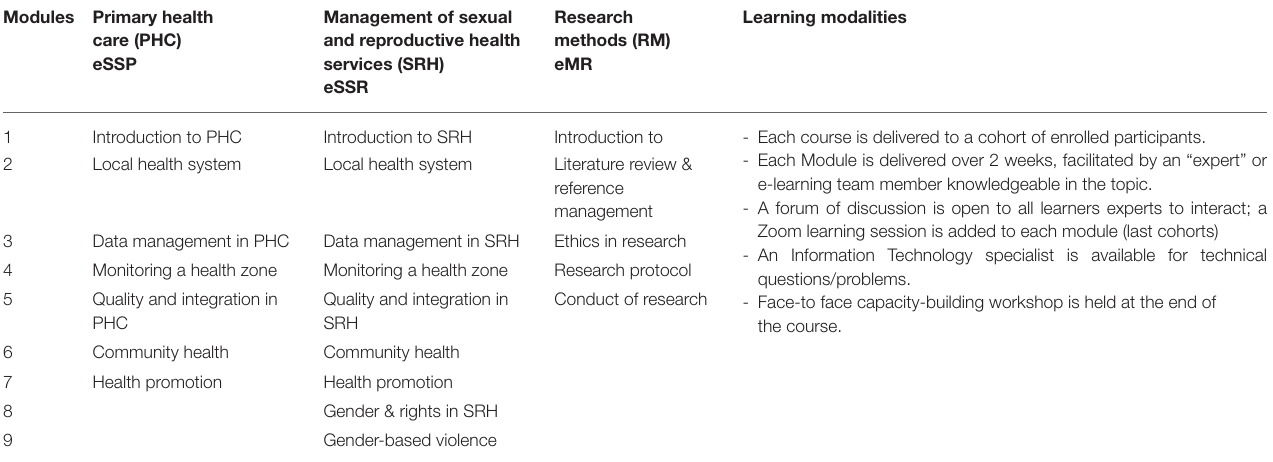
TABLE 1 | Blended courses, modules and learning modalities in Guinea,